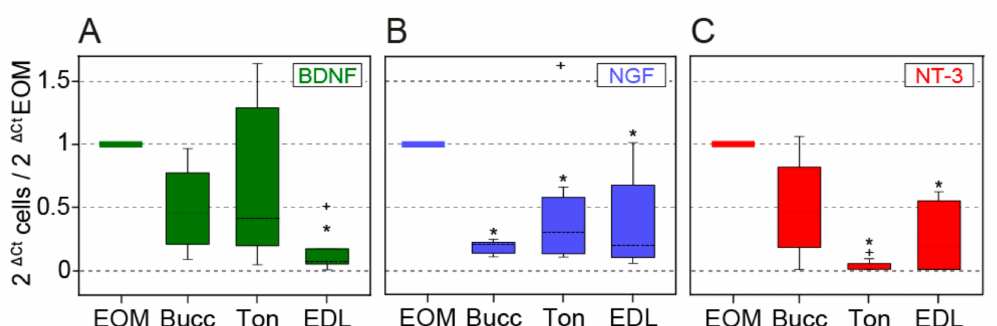
Figure 3. Expression of neurotrophins on cultured cells quantified by RT–qPCR. ( A ) Box-and-whisker plots summarizing RT–qPCR results on expression of brain-derived neurotrophic factor (BDNF) (A), nerve growth factor (NGF) ( B ) and neurotrophin-3 (NT-3) ( C ) on cells derived from EOM, buccinator (Bucc), tongue (Ton) and EDL. The boxes show the 25th, 50th (median) and 75th percentiles, and the whiskers represent the 10th–90th percentile. Plus sign ( + ) shows data points considered outliers (data outside 10th–90th percentile). Data are normalized with respect to those obtained from EOM cells. Asterisk (*) indicates significant di ff erences with cells derived from EOM.